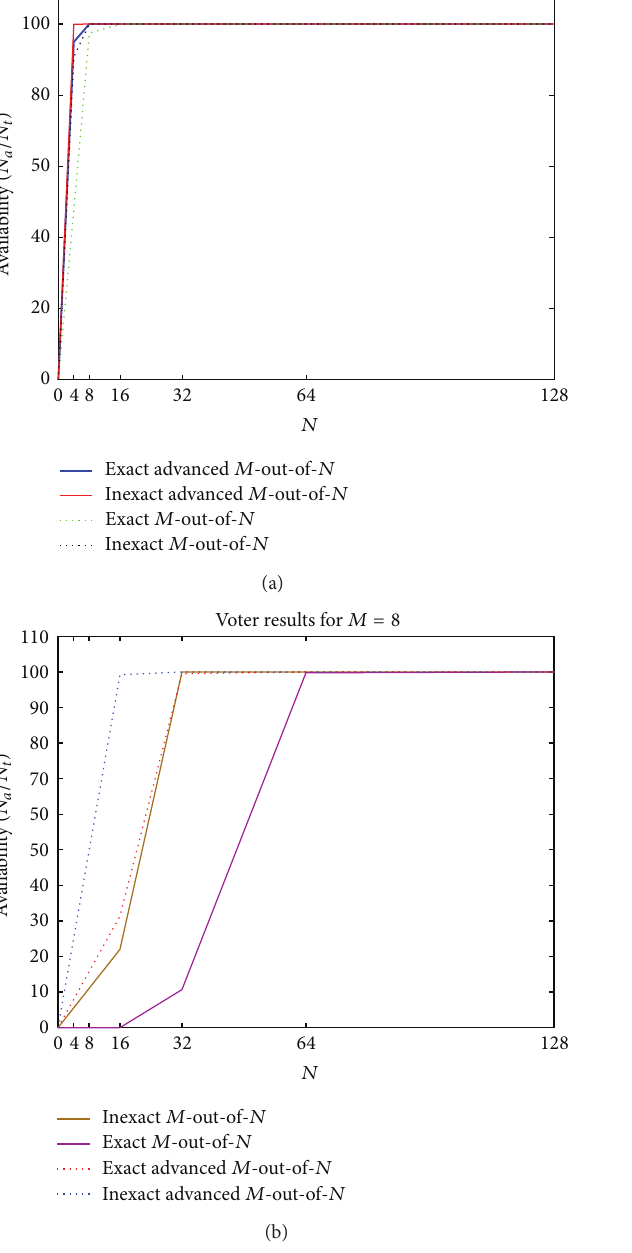
Figure 5: The percentage of correct agreements (reliability) of voting algorithms for (a) 𝑀 = 2 and (b) 𝑀 = 8